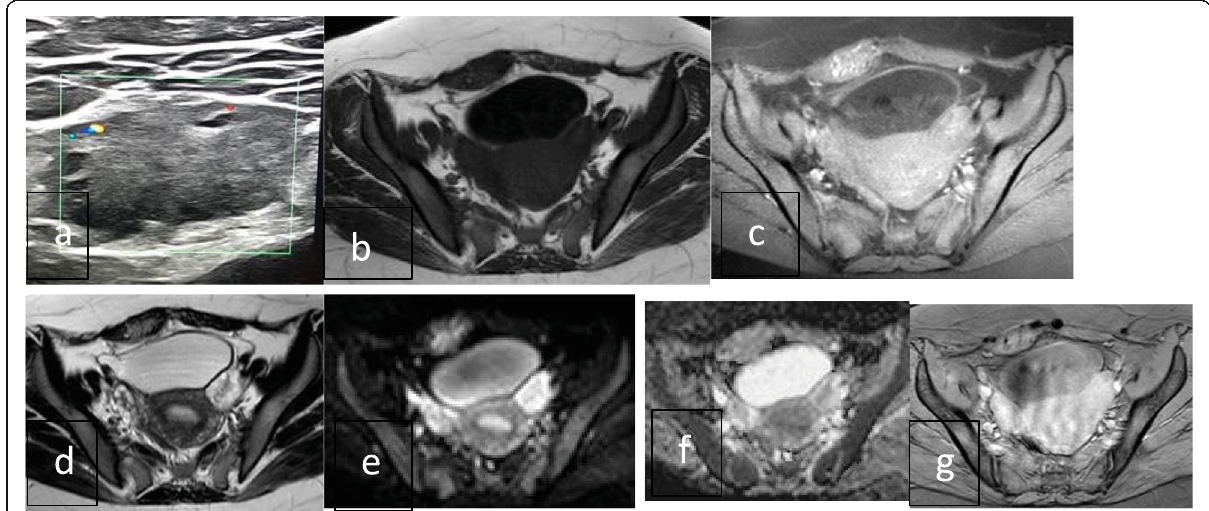
Fig. 4 ( a ) US of the anterior abdominal wall showing a well-defined infiltrative lesion implicating the right rectus muscle, infiltrating both the anterior and posterior rectus sheaths, and eliciting intermediate T1 SI ( b ), with high T1FS ( c ), intermediate T2 SI ( d ). It shows focal areas of diffusion restriction on DWIs ( e , f ), and punctuate signal voids on T2*WI ( g )